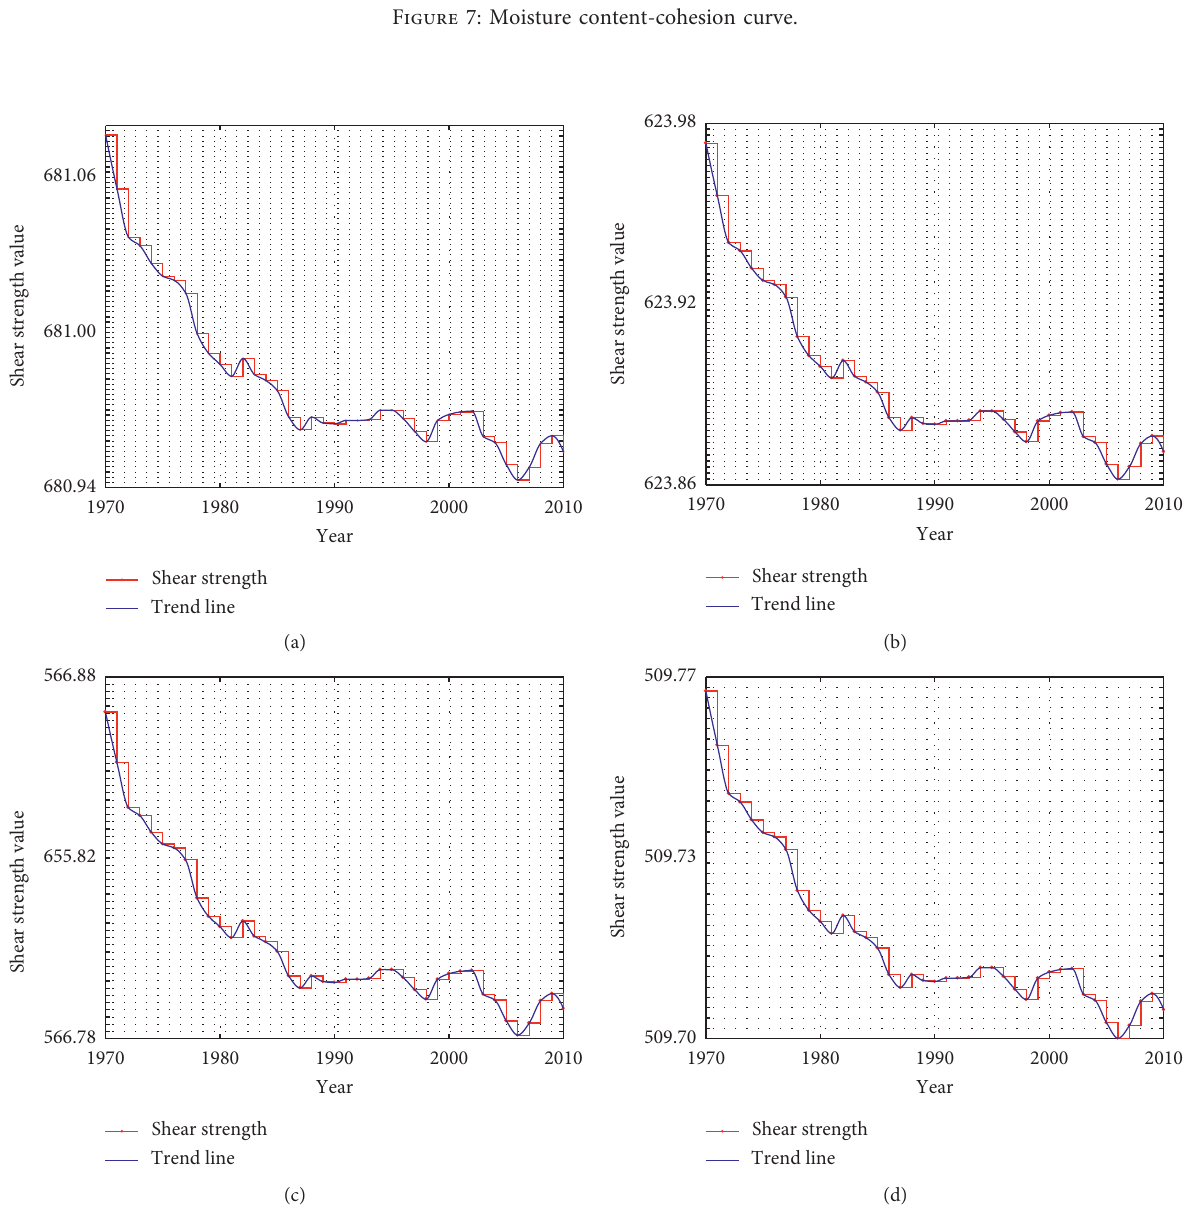
Figure 8: Shear strength-time curve. (a) σ � 100kPa. (b) σ � 200kPa. (c) σ � 300kPa. (d) σ �